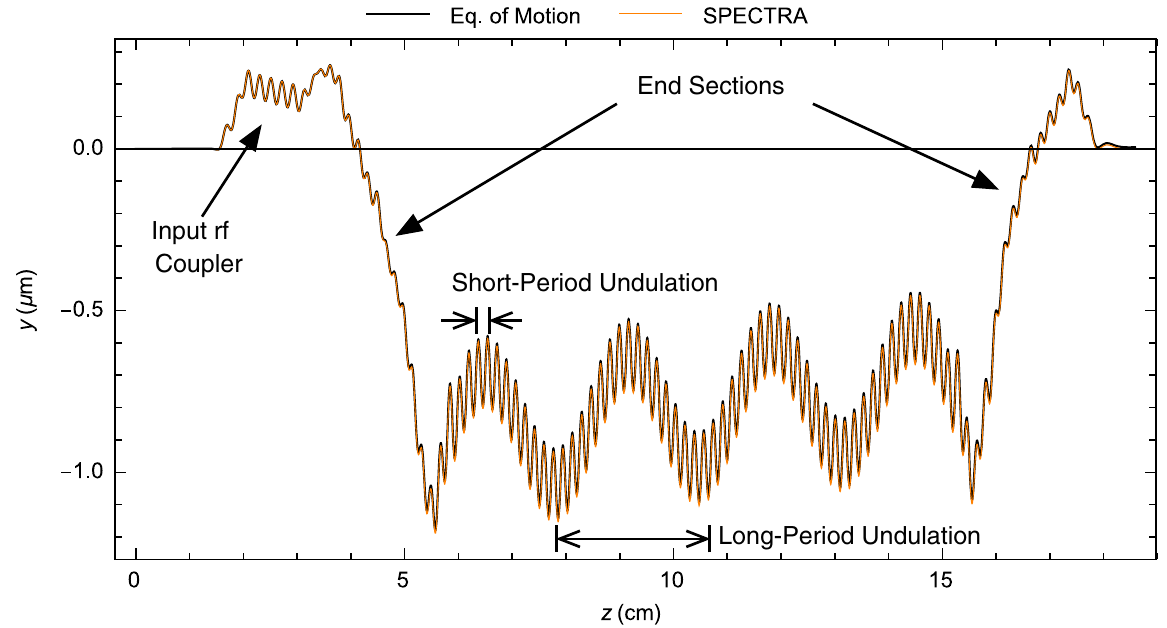
FIG. 32. Single electron orbit inside the rf undulator for K ¼ 0 . 1 , adapted from Toufexis et al. [31]. The black curve was obtained by solving the equations of motion using time varying electric and magnetic fields. The orange curve was obtained from SPECTRA simulation using the equivalent undulator